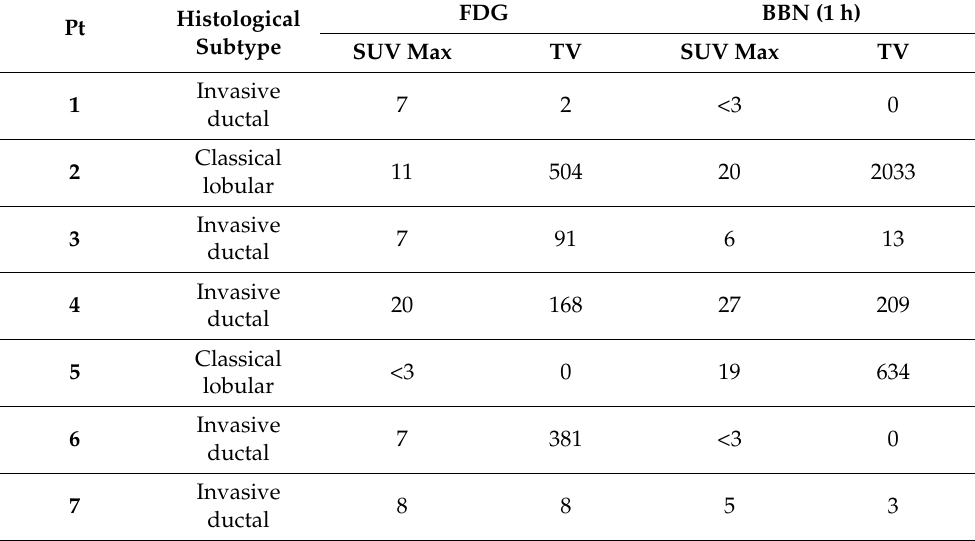
Table 5. Individual patient histological and whole-body quantitation